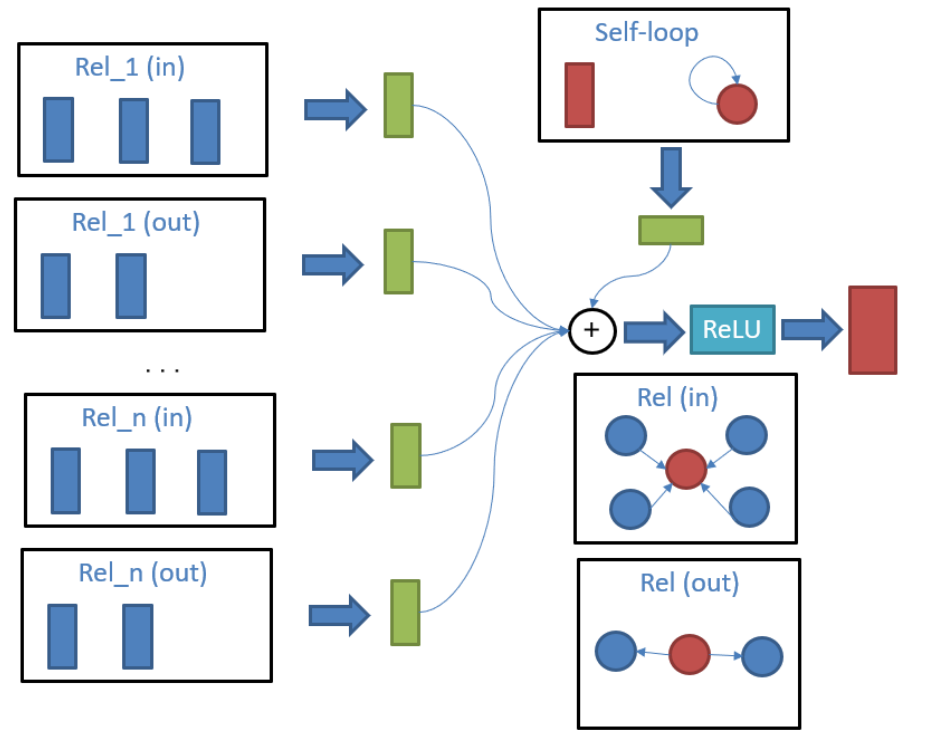
Figure 9. Diagram representing the computation of the update of a single graph node/entity (red) in the R-GCN